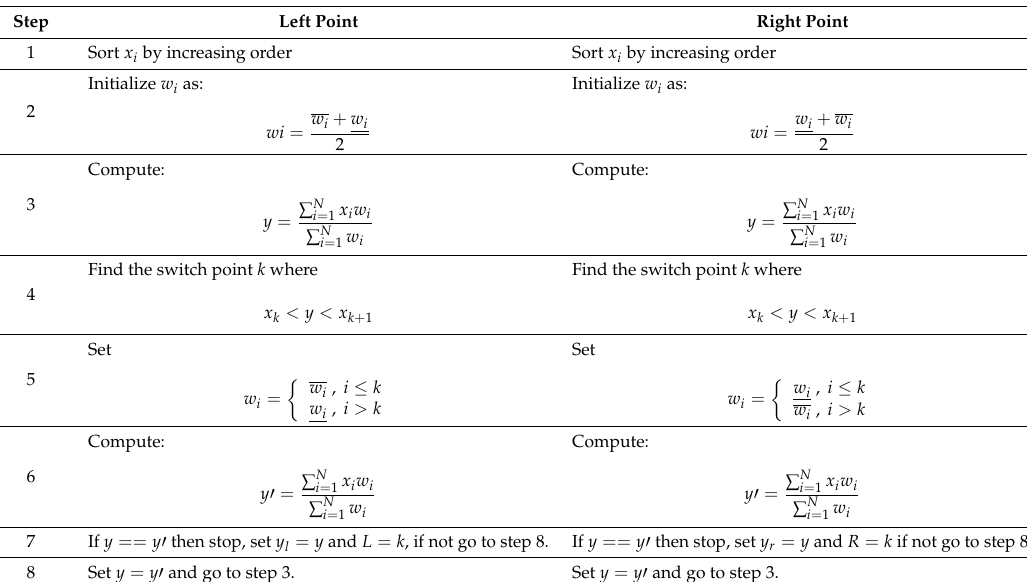
Table 1. Karnik Mendel